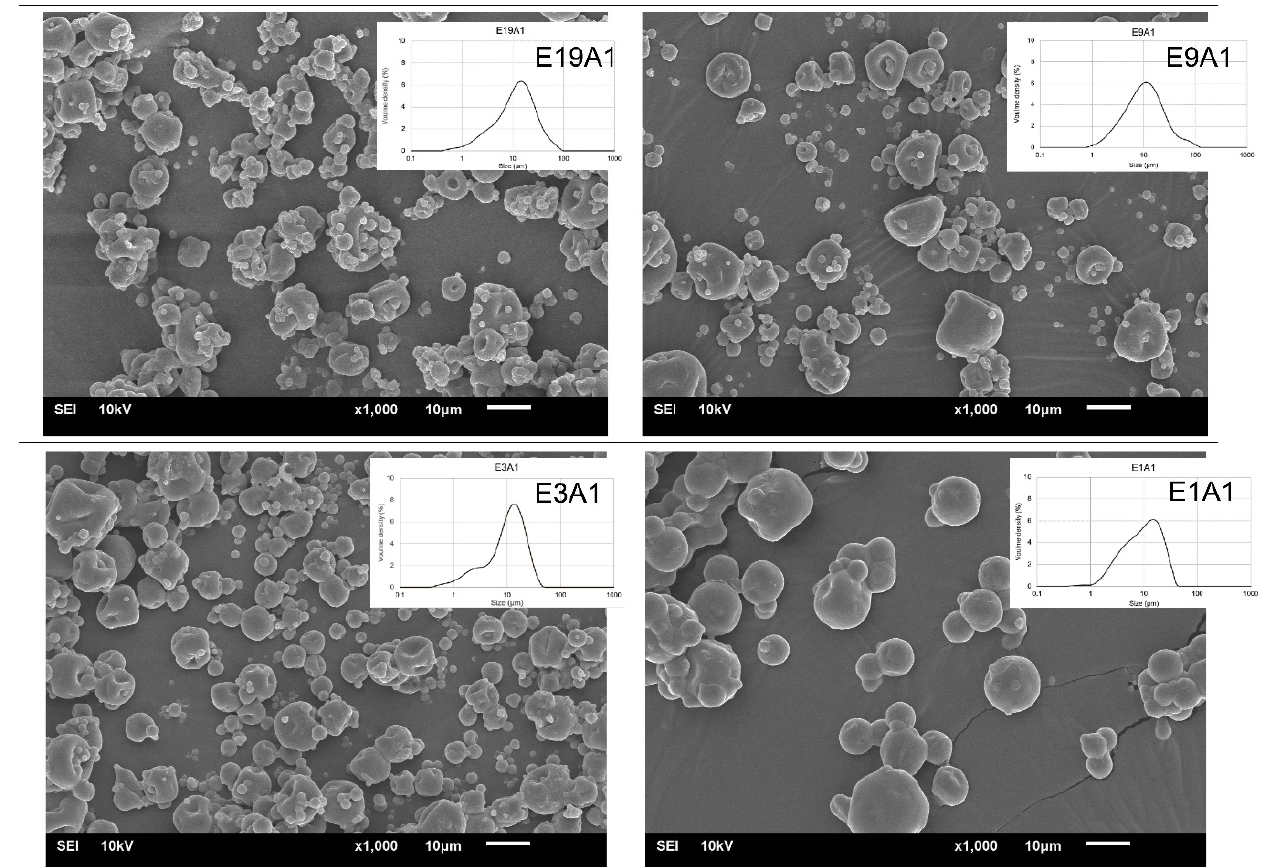
Figure 4. SEM images taken at 1000× magnification of microcapsules E19A1, E9A1, E3A1 and E1A1. All samples were prepared with using CS as a coencapsulation material at a mass ratio of 1.5% of